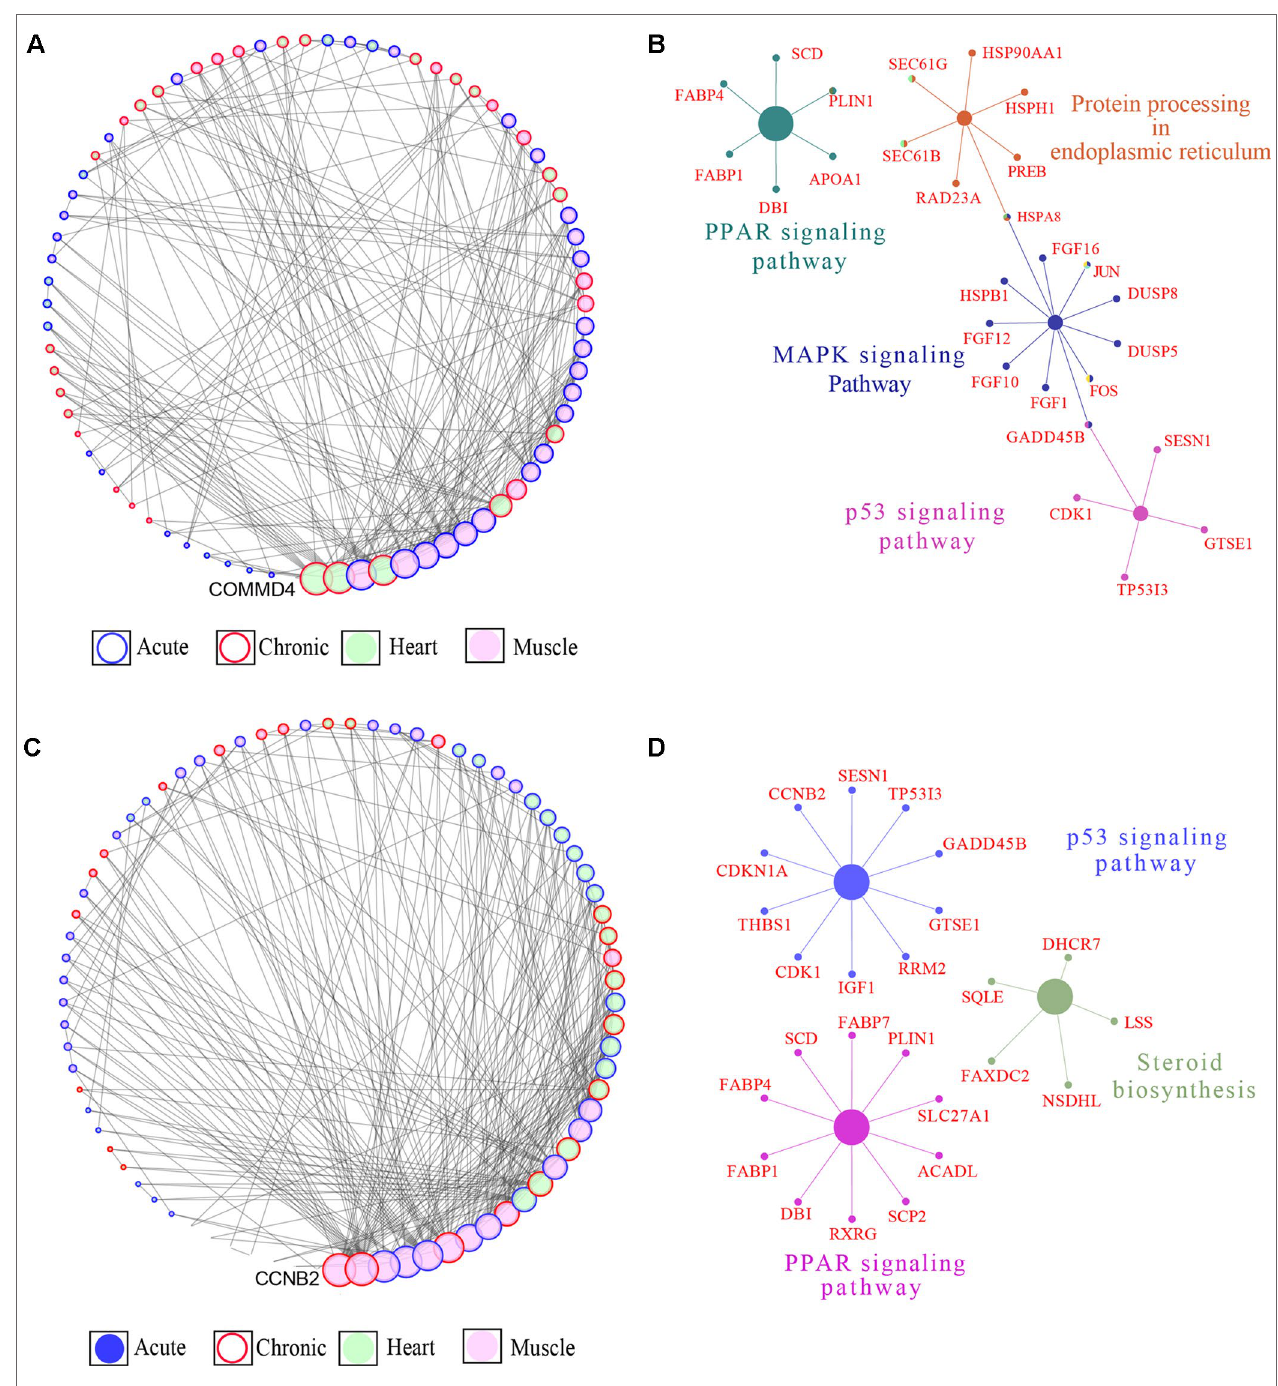
FIGURE 5 | Gene coexpression network (GCN) and pathway enrichment analysis integrated for the skeletal and cardiac muscle DEGs. (A) Degree sorted network of DEGs in at least one contrast in the highland chickens. The nodes are genes, and the edges are based on correlation coefficients. Only genes with a partial correlation | r | of ≥0.99 were included in network. Node color denotes the tissue type in which the gene expression was the highest, while node border denotes the stage at which the gene expression was the highest. (B) KEGG pathway networks in which all the genes in the highland GCN network were enriched. (C) Degree sorted network of DEG in at least one contrast in the lowland chickens. The nodes are genes, and the edges are based on correlation coefficients. Only genes with a partial correlation | r | of ≥0.99 were included in network. Node color denotes the tissue type in which the gene expression was the highest, while node border denotes the stage at which the gene expression was the highest. (D) KEGG pathway networks in which all the genes in the lowland GCN network were